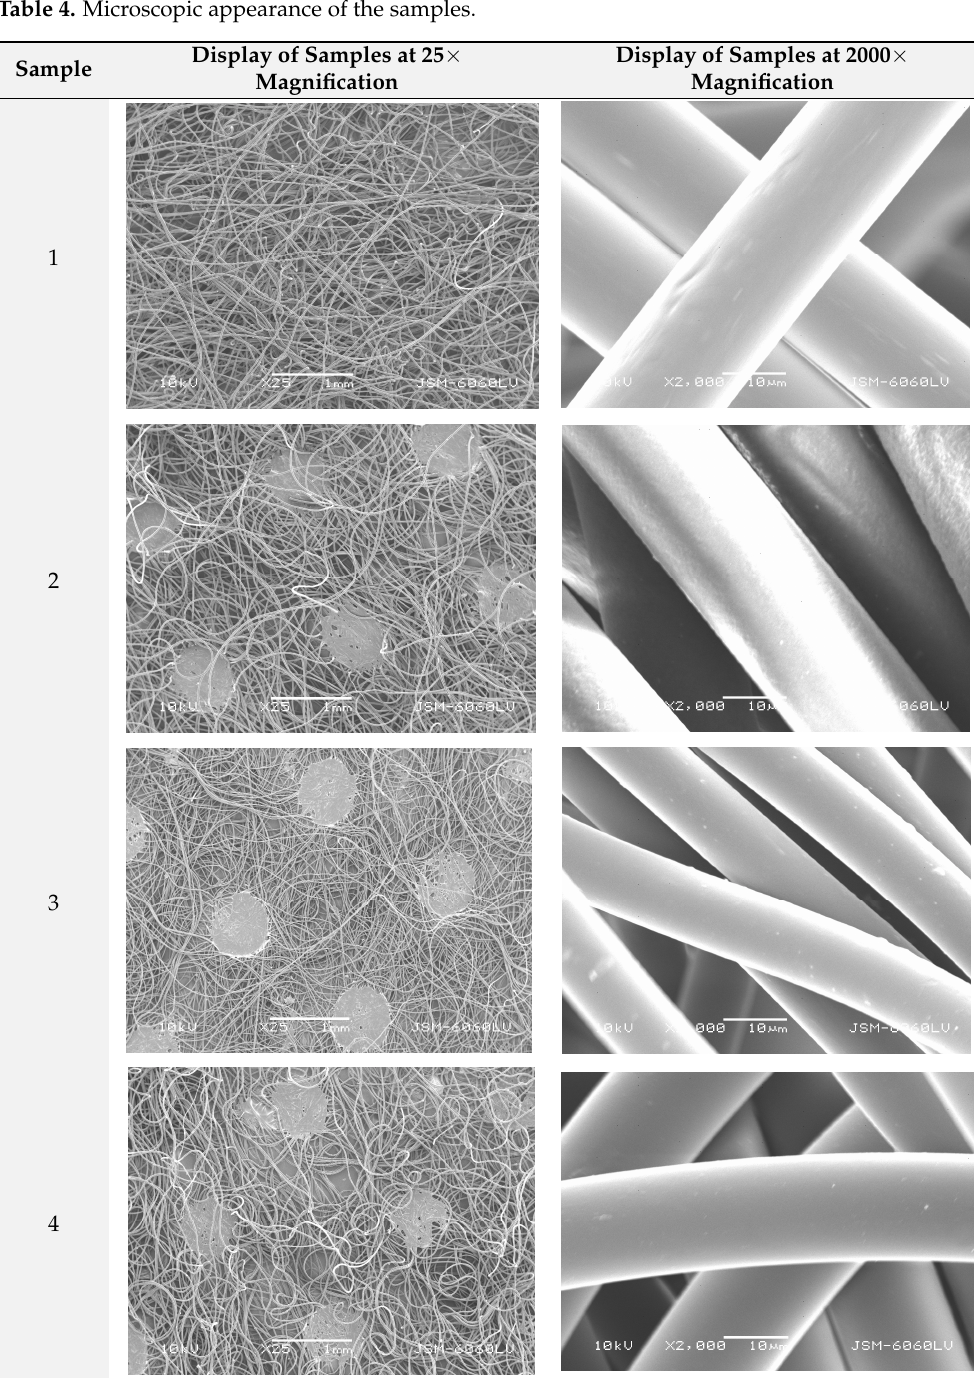
Table 4. Microscopic appearance of the samples.